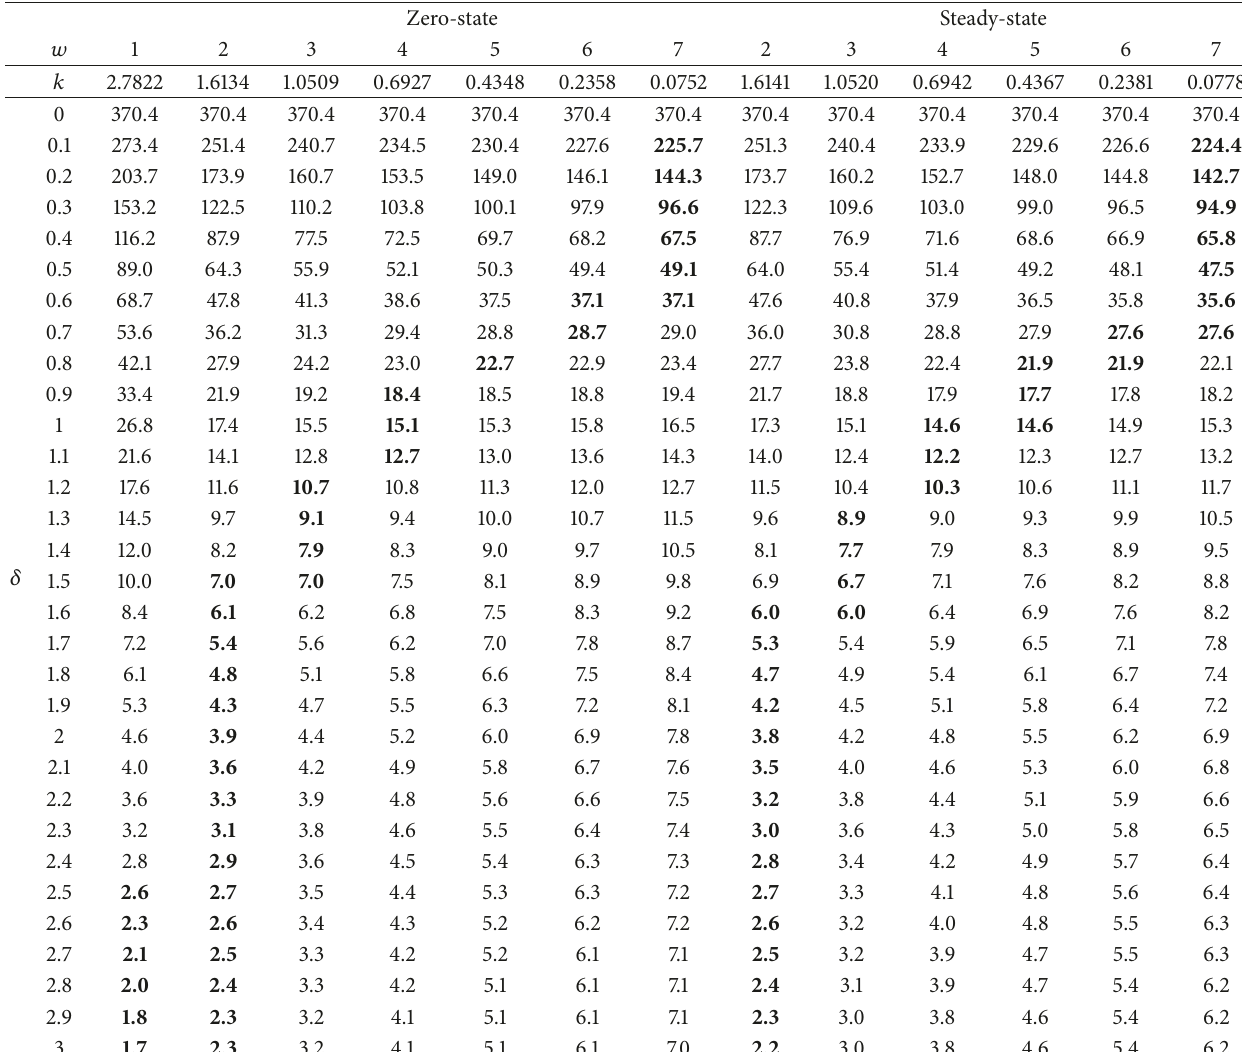
Table 3: The zero- and steady-state ARL for the one-sided w-of-w SRR 𝑋 charts when ARL 0 = 370.4. Zero-state Steady-state